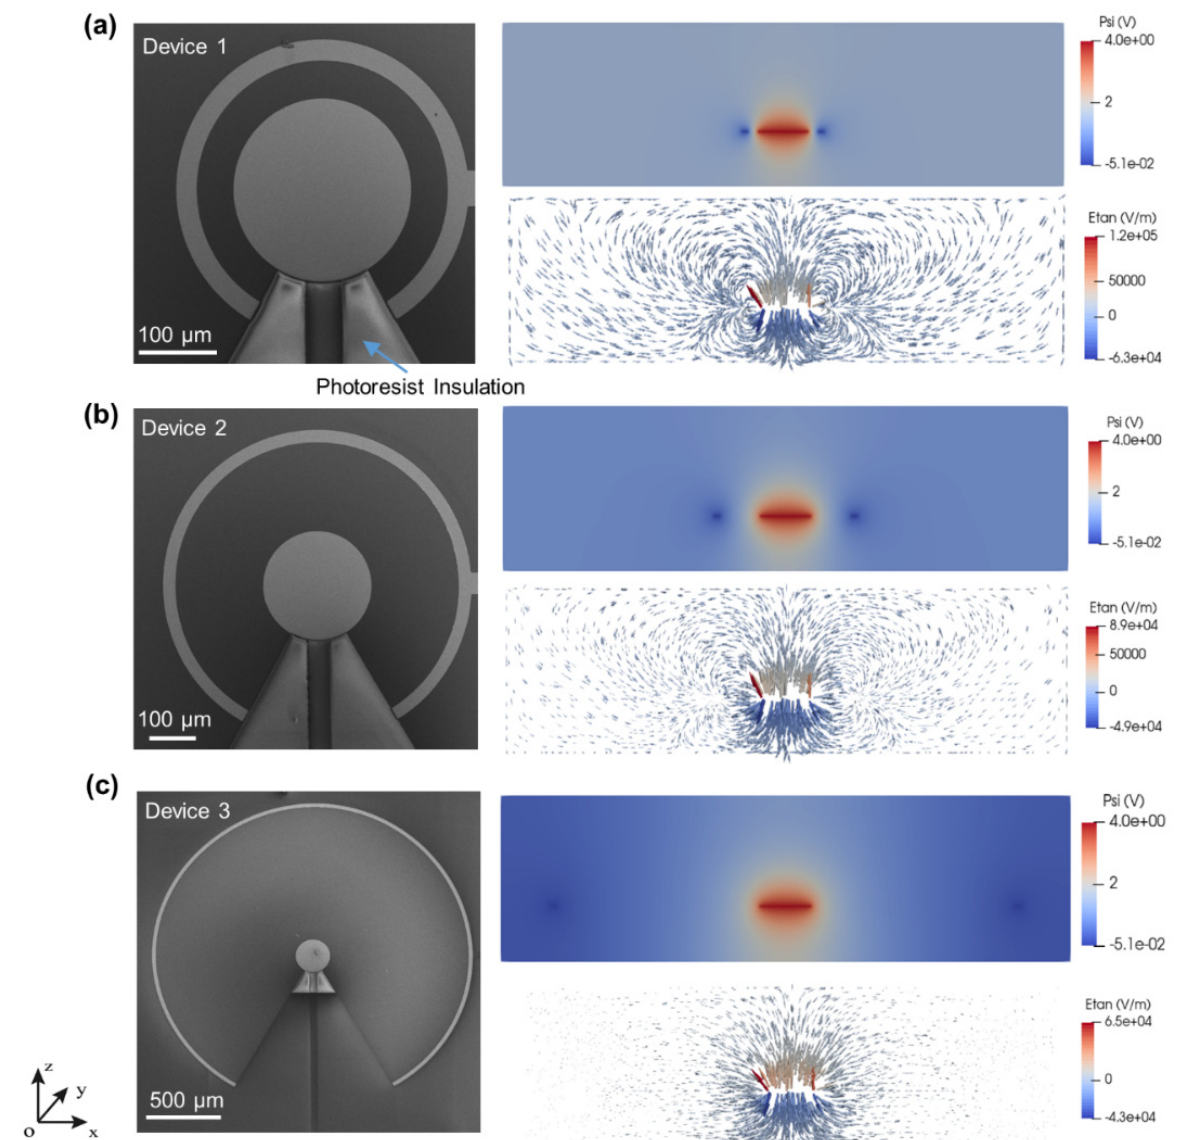
Figure 3. ( a – c ) (left column) shows the SEM images of 2D devices. The right column shows the electric potential and tangential electric field distribution of respective 2D devices on the cross-section of the -xoz plane.